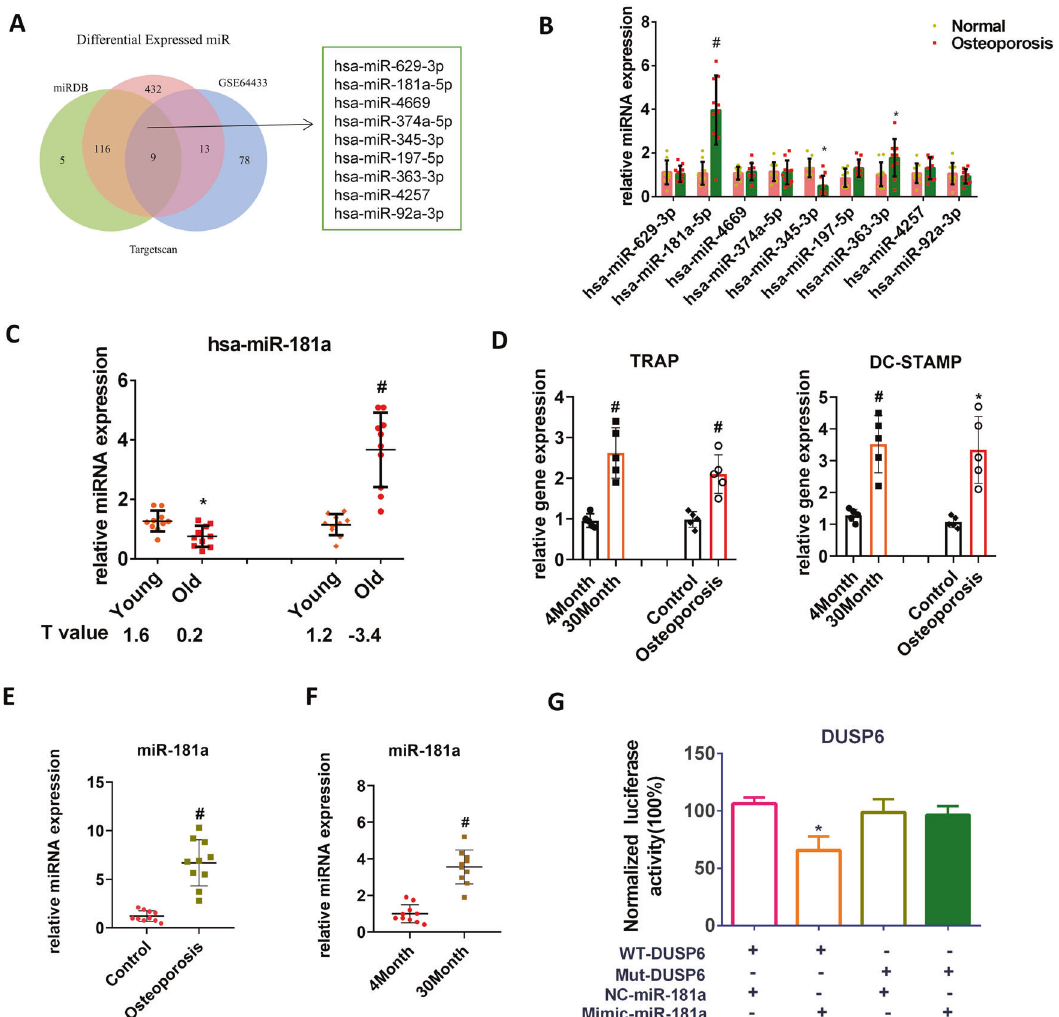
Fig. 5 MiR-181a regulated the DUSP6 gene expression in osteoporotic bone tissues. A Bioinformatics approach using existed databases was used to fi nd the regulator of DUSP6. Two databases (TargetScan and miRDB) were used to explore the potential miRNAs regulating the DUSP6. And the GSE64433 form the NCBI was used to shown the differential miRNAs between osteoporosis and normal group. The overlapping miRNAs were identi fi ed as potential regulator of DUSP6 during the osteoporosis condition. B Real-time PCR was carried out to con fi rm the nine miRNAs in human osteoporotic and normal bone tissues. n = 10. C Human samples were collected and classi fi ed as young (range from 22 to 58 years old) and old (range from 62 to 87 years old) person. And they were then divided as normal and osteoporosis groups. The average T value was shown in the indicated group. And the hsa-miR-181a (has-miR-181a-5p) expression was evaluated using real- time PCR. Ovariectomy-induced osteoporosis model ( D ) and age-related osteoporosis model ( E ) was established to explore the expression of miR-181a (mmu-miR-181a-5p). F mRNA was isolated in the tibia in mice from the indicated group. The expression of osteoclast-related gene was analyzed using real-time PCR. G Normal and mutated luciferase reporter containing putative miR-181a target sites of DUSP6 was established. The luciferase reporter vectors were cotransfected into HEK293 cells with miR ‐ 181a mimics/inhibitor. The luciferase activity was quanti fi ed. Data in all bar graphs are expressed as mean ± SD. * P < 0.05, # P <